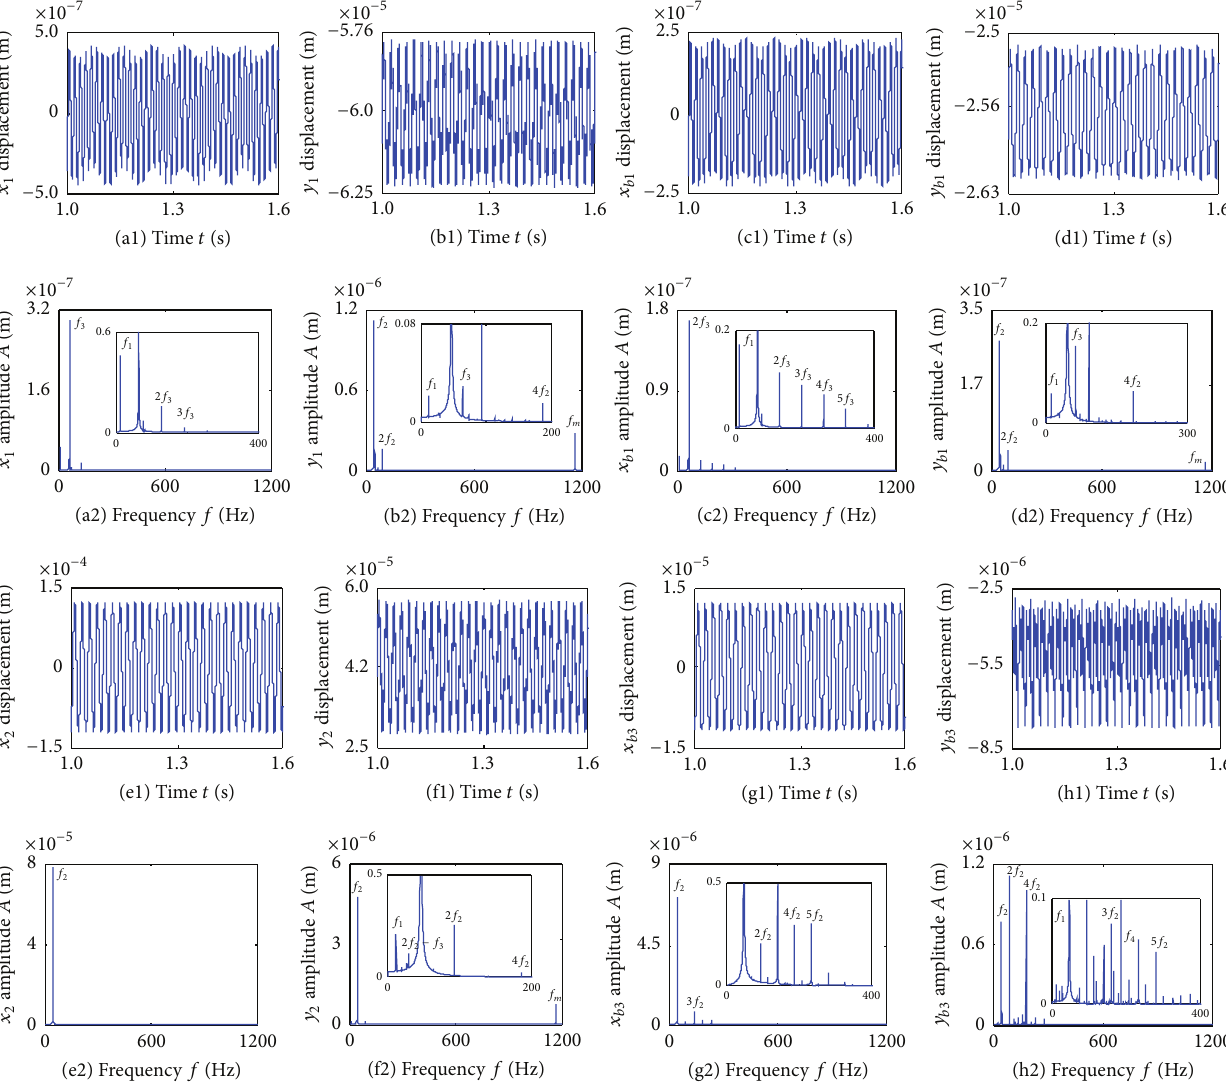
fluctuation trend is almost invariant. For the driving gear, the vibration amplitude in 𝑦 -direction is obviously higher than that in 𝑥 -direction. It also can be found from the 3D frequency spectrum that the variable stiffness